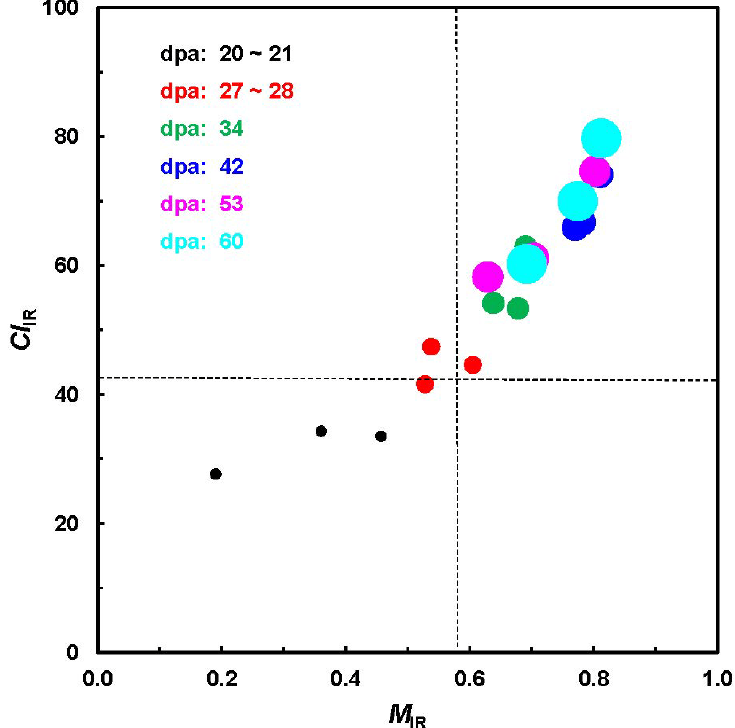
against CI values from ATR-FTIR procedure. IR IR